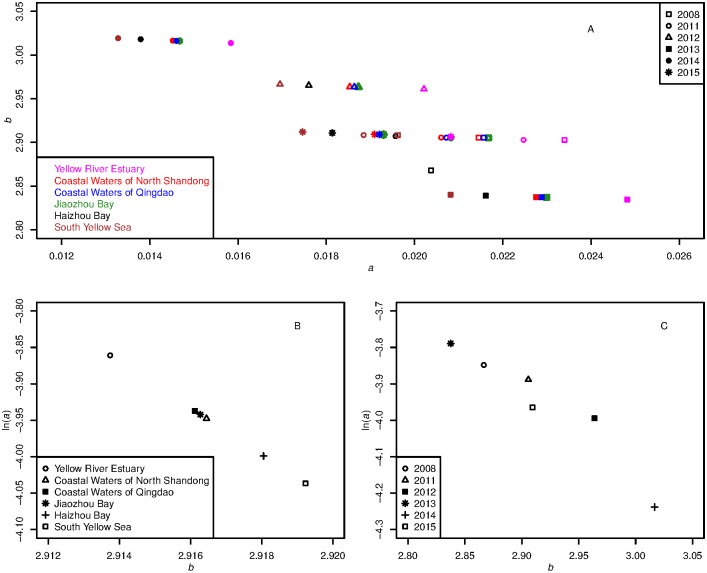
Variations of a and b among regions and years from the LMEM (R&Y.I&S).A: estimates of parameter a and b with random effects of both regions (presented in various colors) and years (presented in various markers). B: spatial variations of ln(a) and b. C: temporal variations of ln(a) and b.